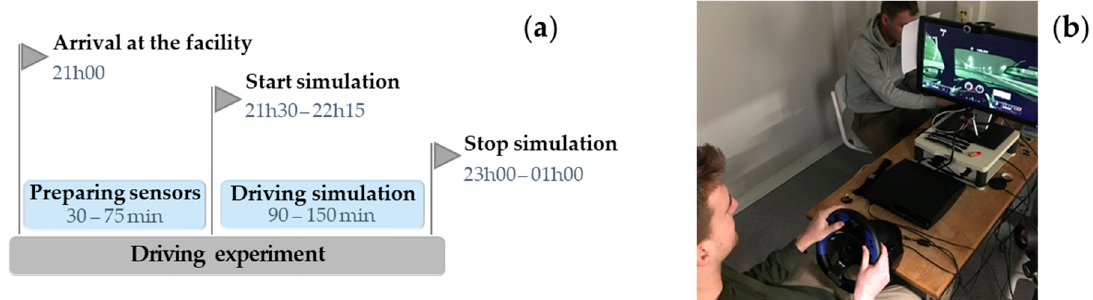
Figure 1. Timing of the driving experiment ( a ) and a photo of the driving simulator installed in the climate-controlled room ( b ).